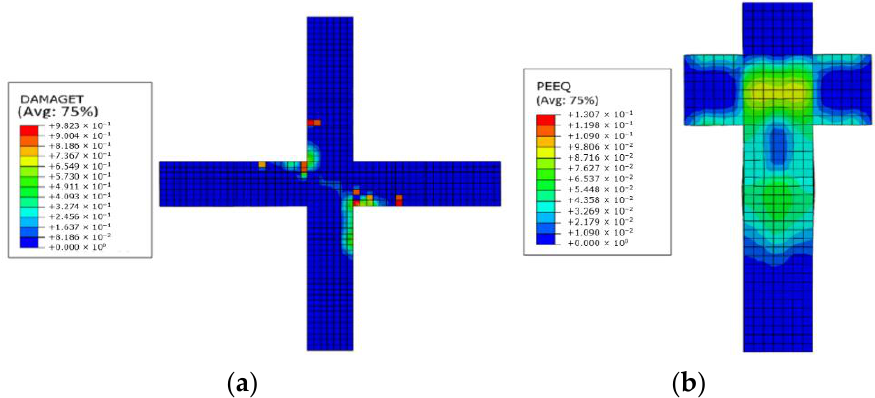
Figure 9. Contours of equivalent plastic strain and concrete tensile damage: ( a ) concrete tensile damage; ( b ) equivalent plastic strain.